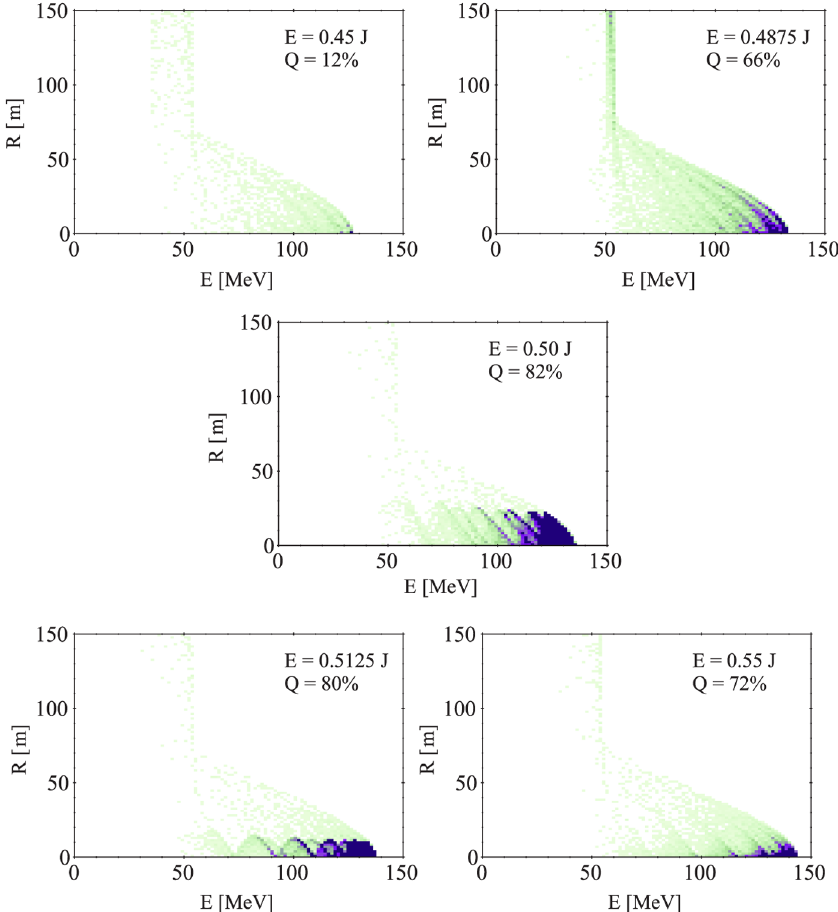
FIG. 12. (Color) Density plot of the radial distribution vs energy for electron bunches injected 300 fs in front of the laser pulse in the bunch after exiting the plasma channel with a plasma wave of a 0 ¼ 0 : 32 for various laser energy variations given in Fig.